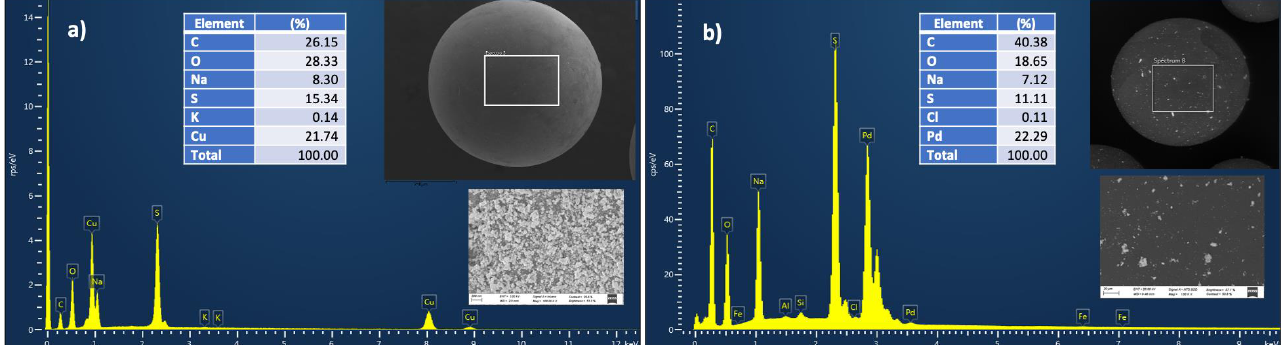
Figure 1. ( a ) EDX and FESEM of IRA-120-Cu(0) catalyst for CuAAC. ( b ) IRA-120-Pd(0) for Heck reactions (see graphics in detail in supplementary material Figure S2).